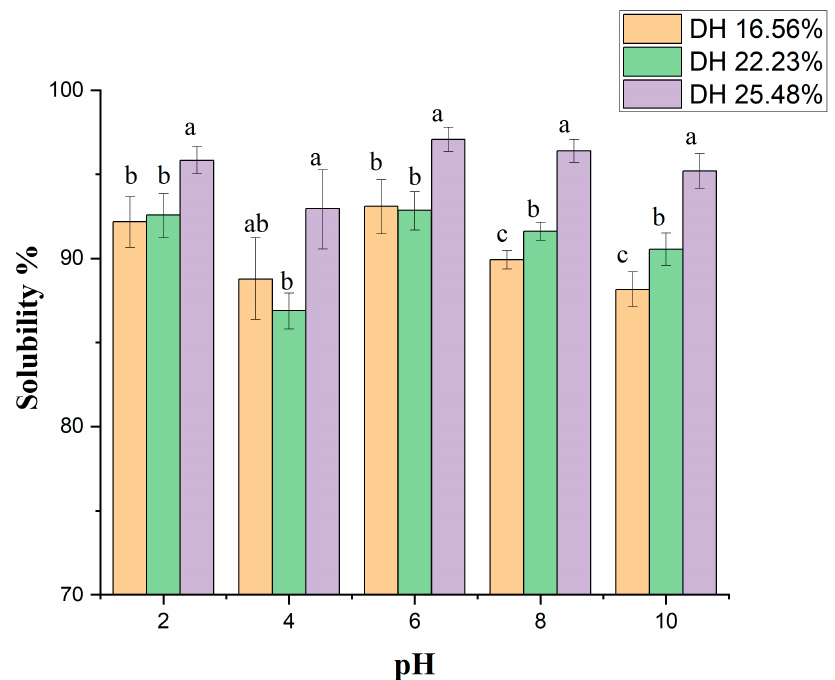
Figure 6. Protein solubility of hydrolysates obtained at different degrees of hydrolysis at pH values ranging from 2 to 10. The values represent mean ± SD (n = 3), and various letters indicate that the values are significantly different ( p ≤ 0.05).